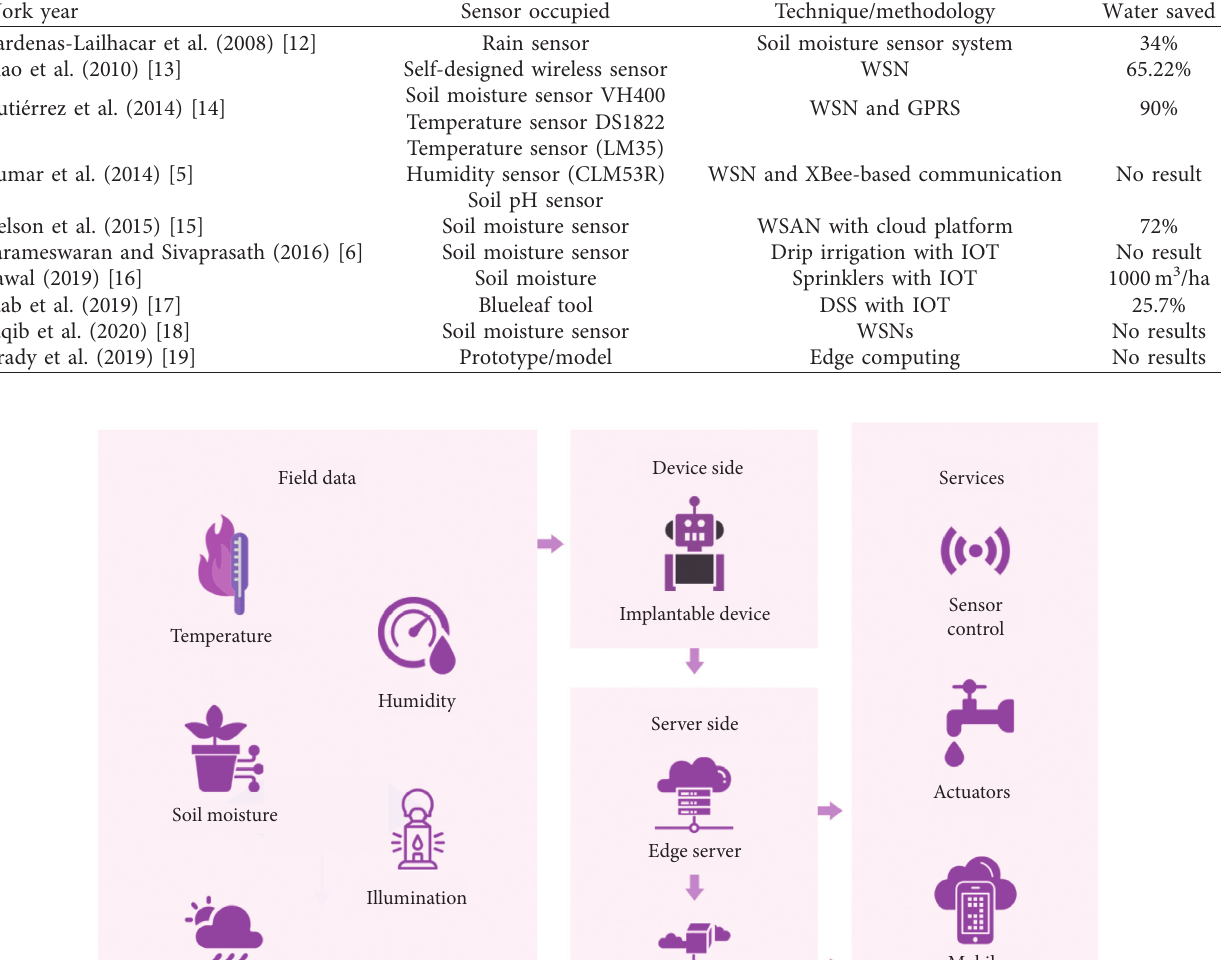
Table 1: Sensor-based